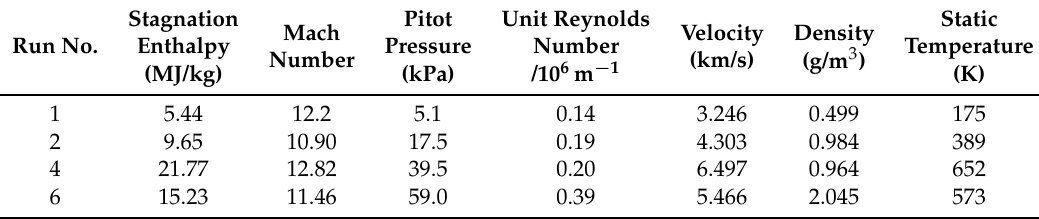
Table 1. Freestream conditions for double-cone